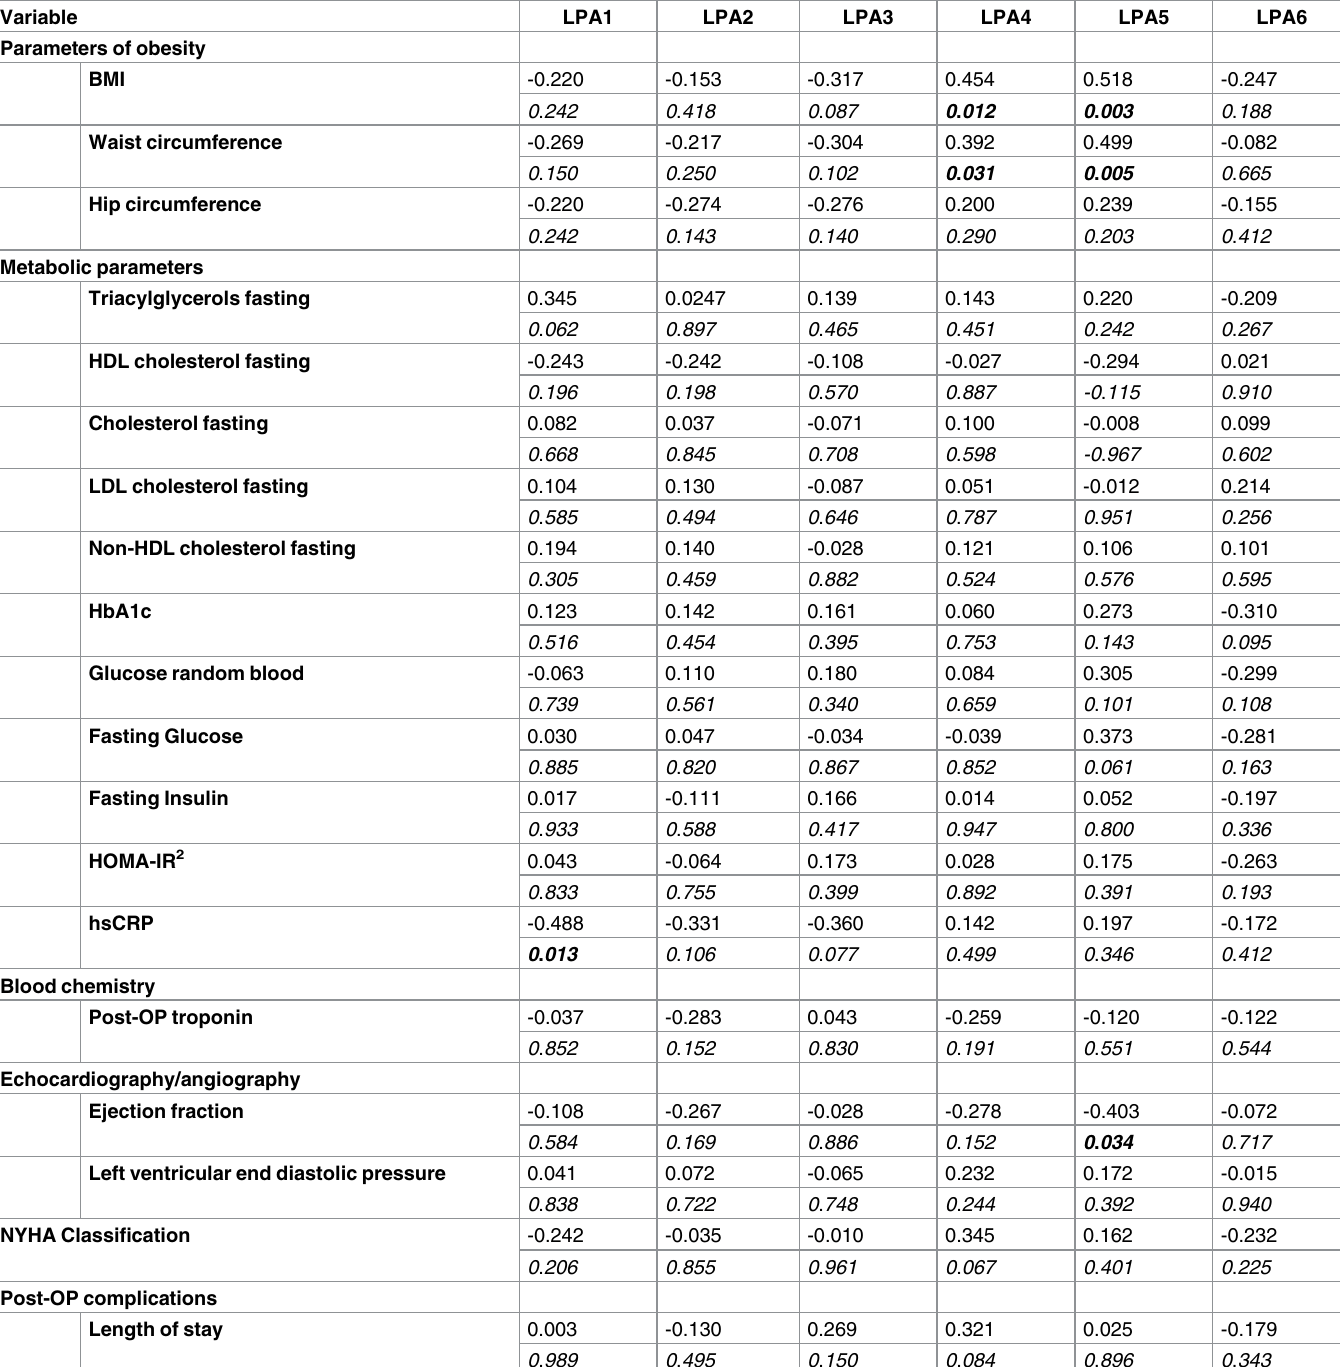
Table 6. Unadjusted Pearson’s correlations of LPA receptors in atrial appendage from cardiac surgery